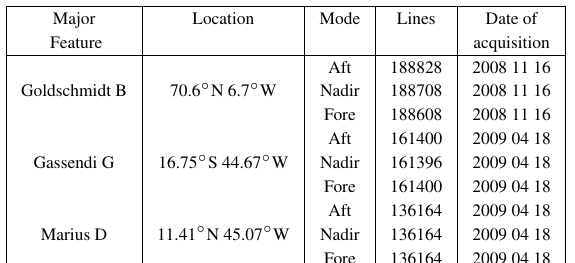
Table 1: TMC Data-set details